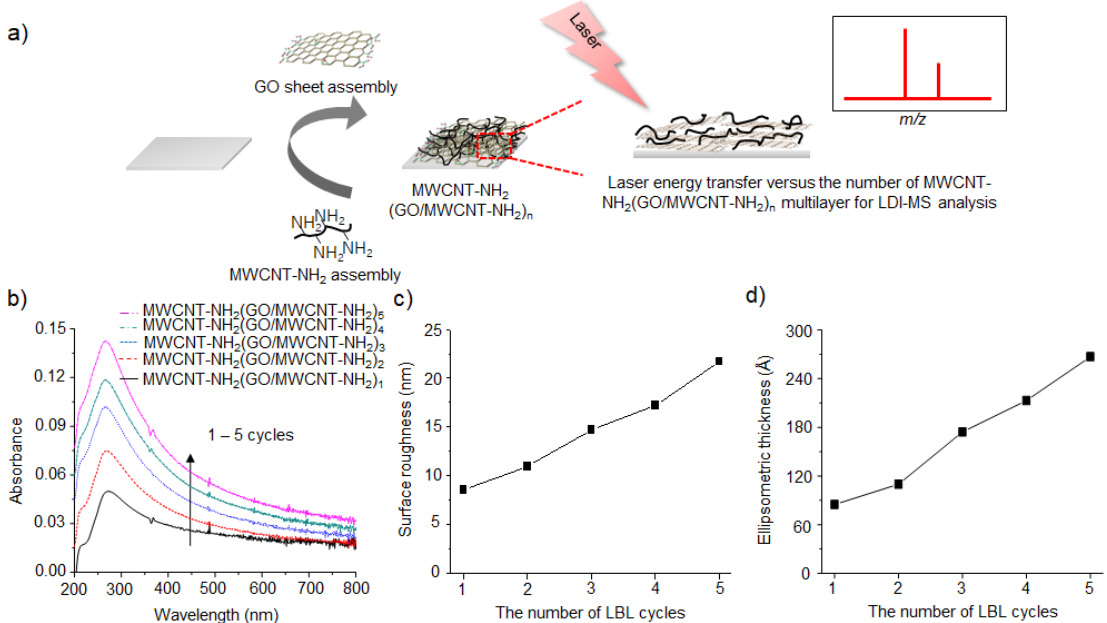
Figure 5. ( a ) Fabrication process, ( b ) UV-Vis absorption spectra, ( c ) surface roughness and ( d ) ellipsometric thickness of GO and MWCNT-NH 2 nanohybrid films prepared with the different number of LBL assembly cycles. Adapted with permission from ref. [72]. Copyright 2012 American Chemical Society.